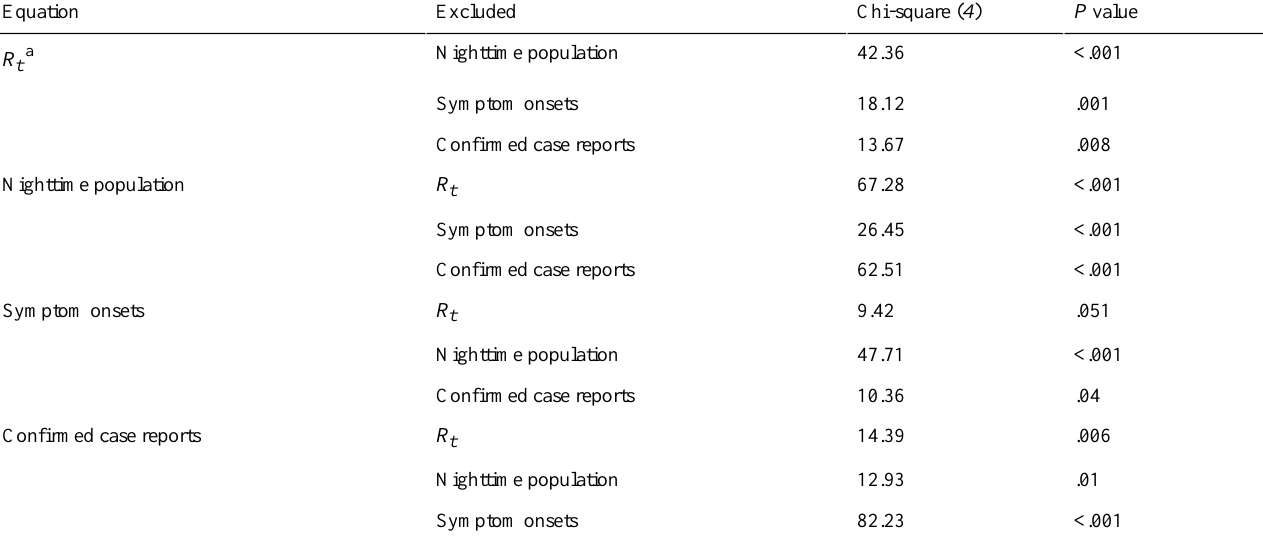
Table 2. Granger causality tests of pairs between nighttime population, symptom onsets, confirmed case reports, and R t .